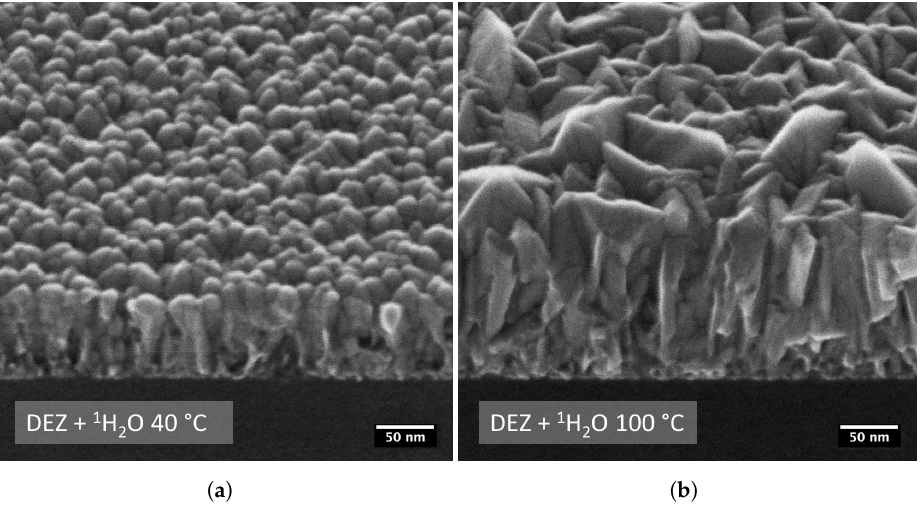
Figure 4. Cross-sectional HIM images of ZnO films deposited with normal water at ( a ) 40 ◦ C and ( b ) 100 ◦ C. The cleaved samples are imaged at a 45 ◦ angle relative to the beam.